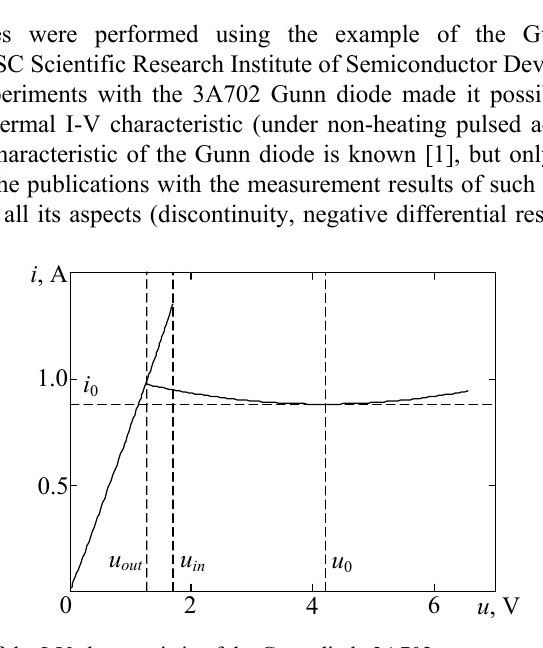
Fig. 2. The model of the I-V characteristic of the Gunn diode